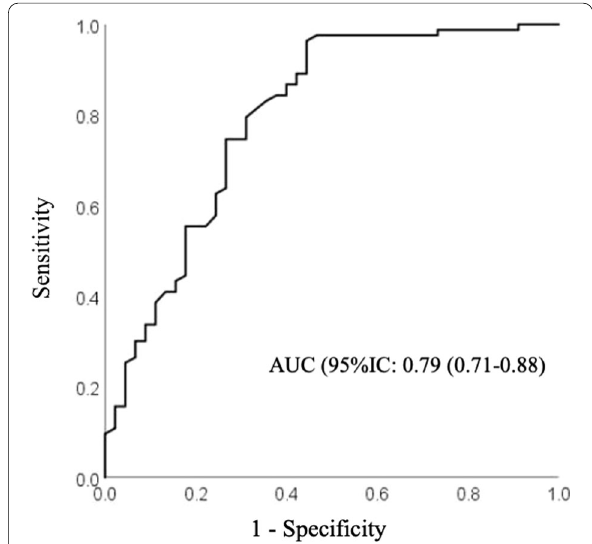
Fig. 1 ROC curve for the performance of RAPID3 in relation to the gold standard